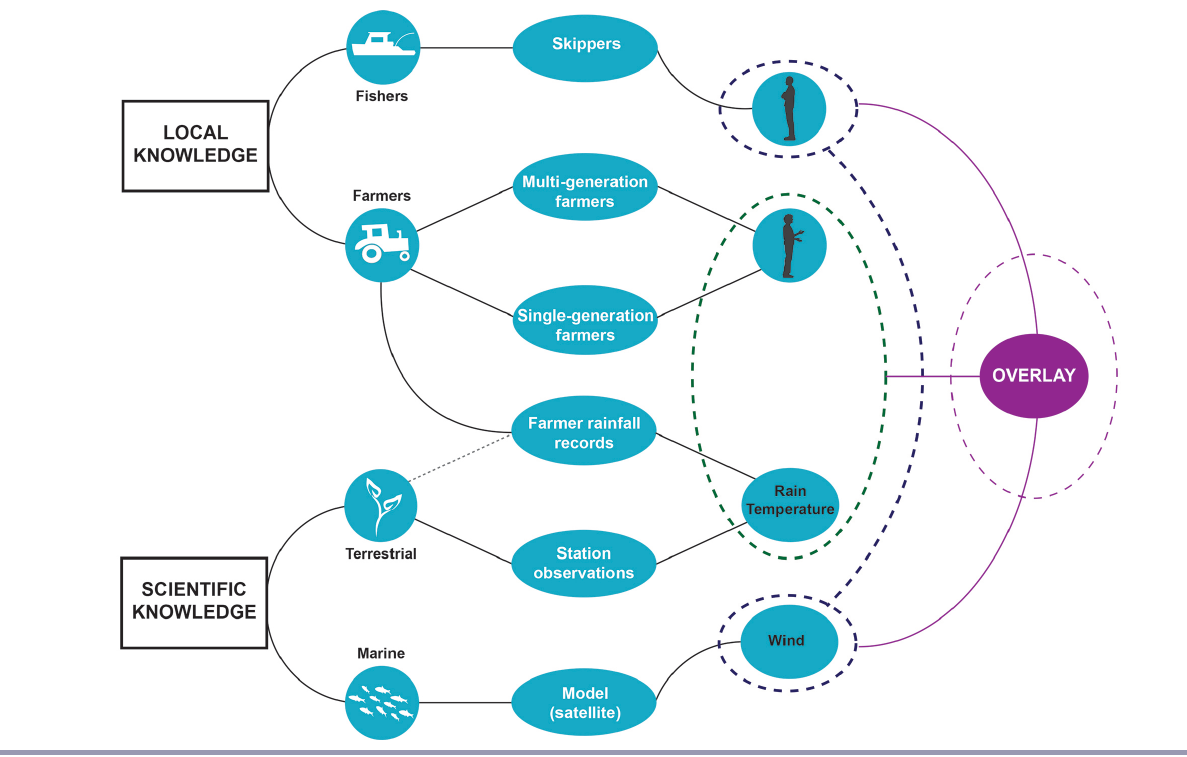
Fig. 2 . Different strands of knowledge examined and how they are brought into dialogue for this